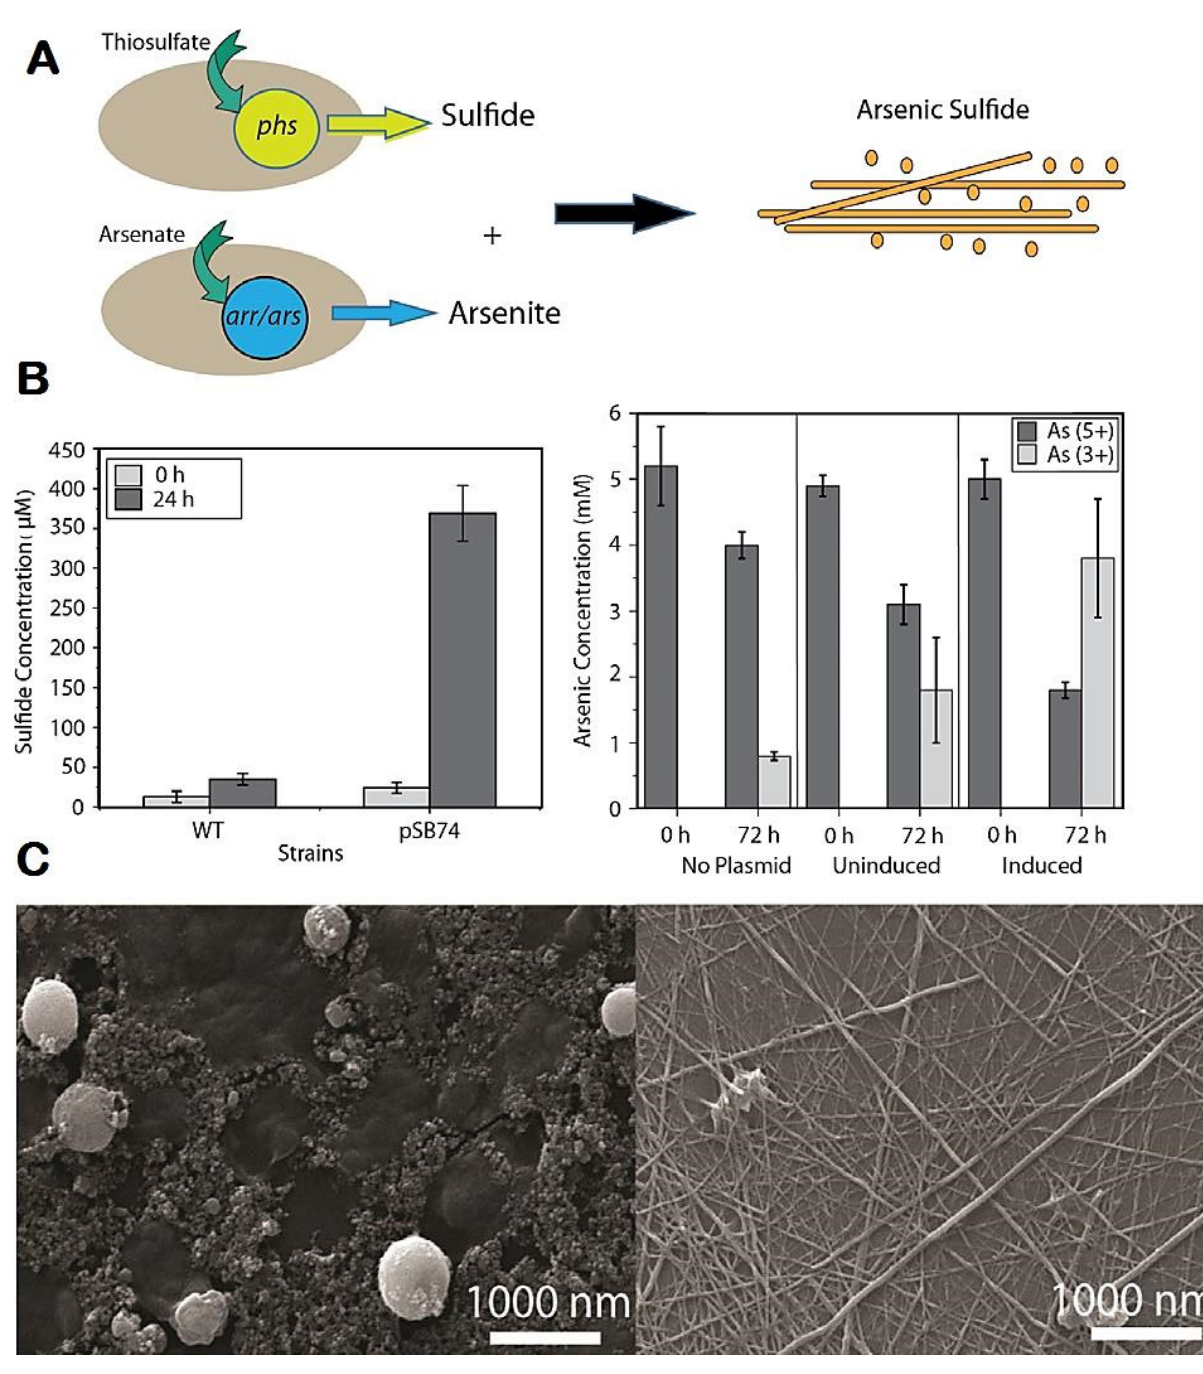
Figure 2. ( A , B ) Genetically modified E. coli strains applied for the bioreduction of thiosulfate into sulfide in addition to the arsenate into arsenite to synthesize arsenic sulfide chalcogenide nanomaterials ( C ). Adapted from Ref [78] with permission. Copyright 2018 John Wiley & Sons Ltd. (CC BY 4.0).